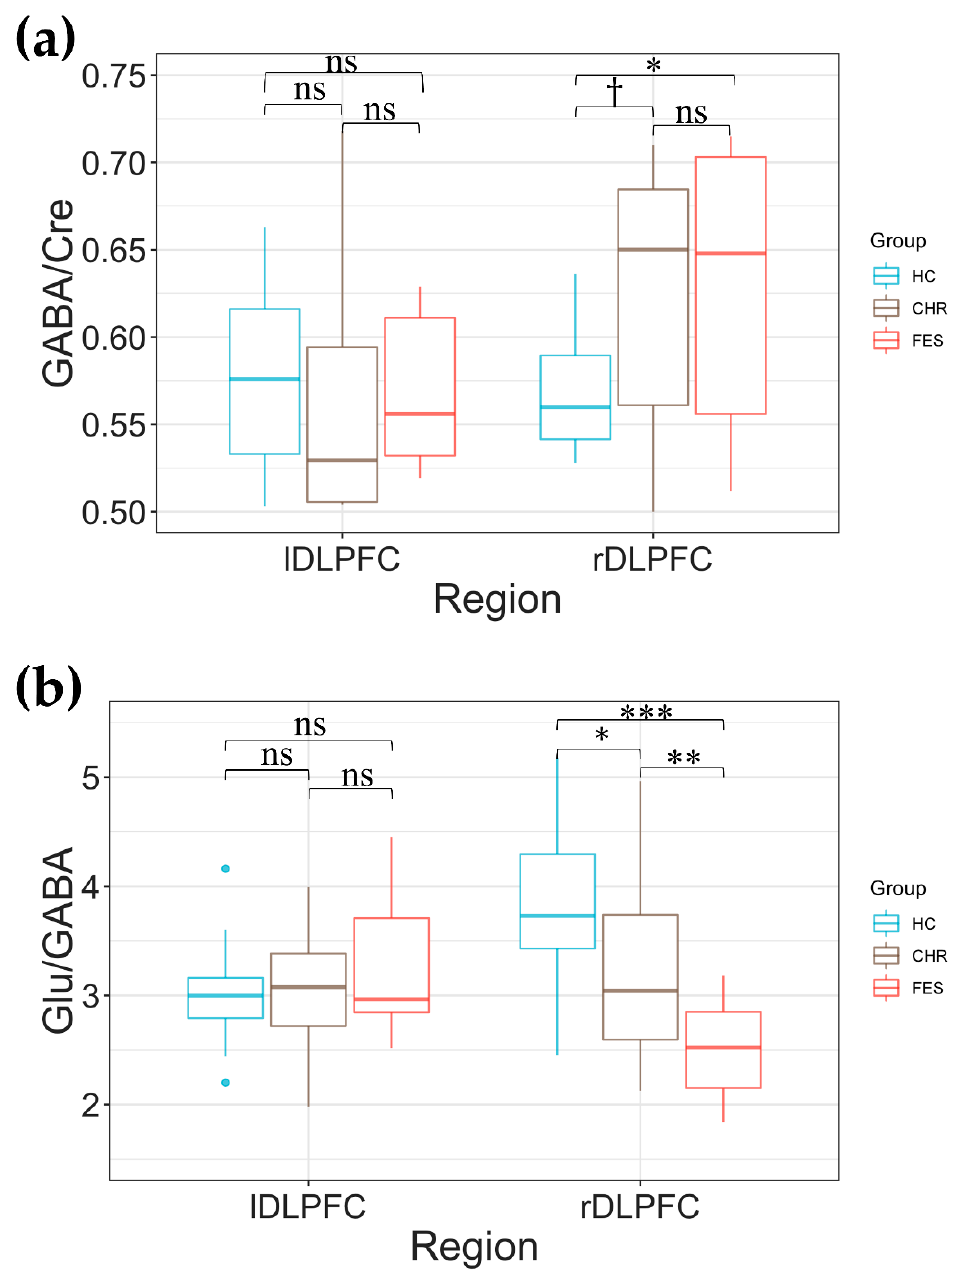
Figure 1. Box plots displaying the right and left dorsal lateral prefrontal cortex (rDLPFC and lDLPFC) GABA/Cre ( a ) and Glu/GABA ( b ) in healthy control (HC), clinical high risk (CHR), and first episode psychosis (FES) individuals. The p values are corrected for multiple comparisons using the false discovery rate method: ns represents non-significant differences, † p < 0.10, * p < 0.05, ** p < 0.01, and *** p < 0.001.